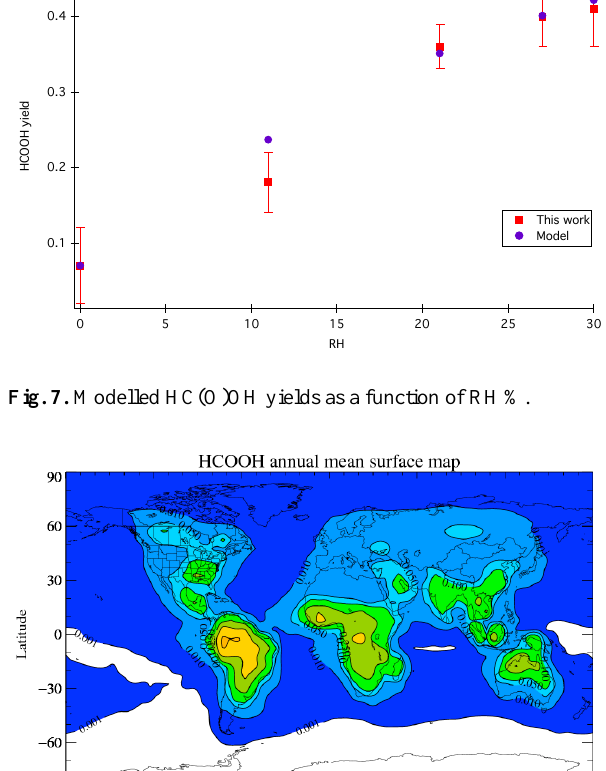
Figure 7 : Modelled HC(O)OH yields as a function of RH %.